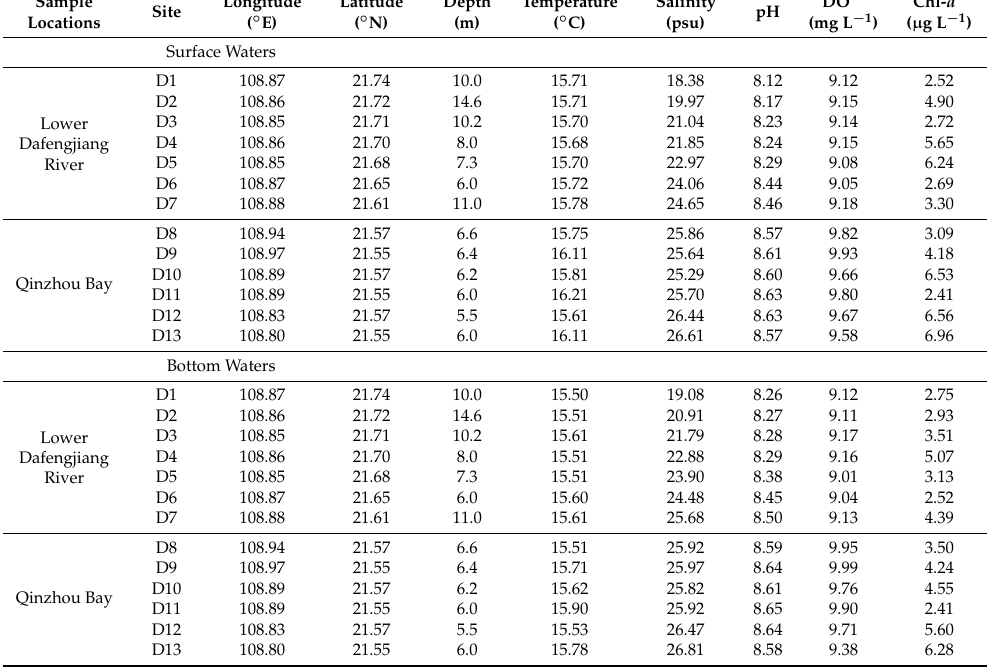
Table 1. Sampling locations, station, water depth, temperature, salinity, pH, dissolved oxygen, and chlorophyll a (Chl- a ) in the Dafengjiang River estuary during December